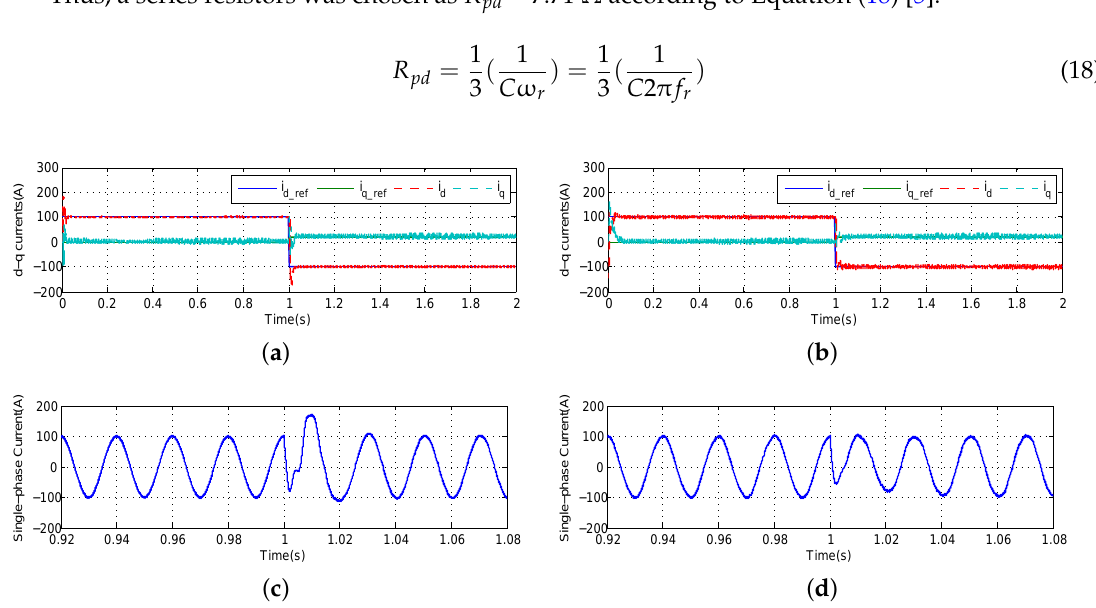
Figure 12. Comparisons for LC filter-based GCC. ( a ) Conventional vector control: d - q currents; ( b ) NN vector control: d - q currents; ( c ) conventional vector control: single-phase current; ( d ) NN vector control: single-phase current.